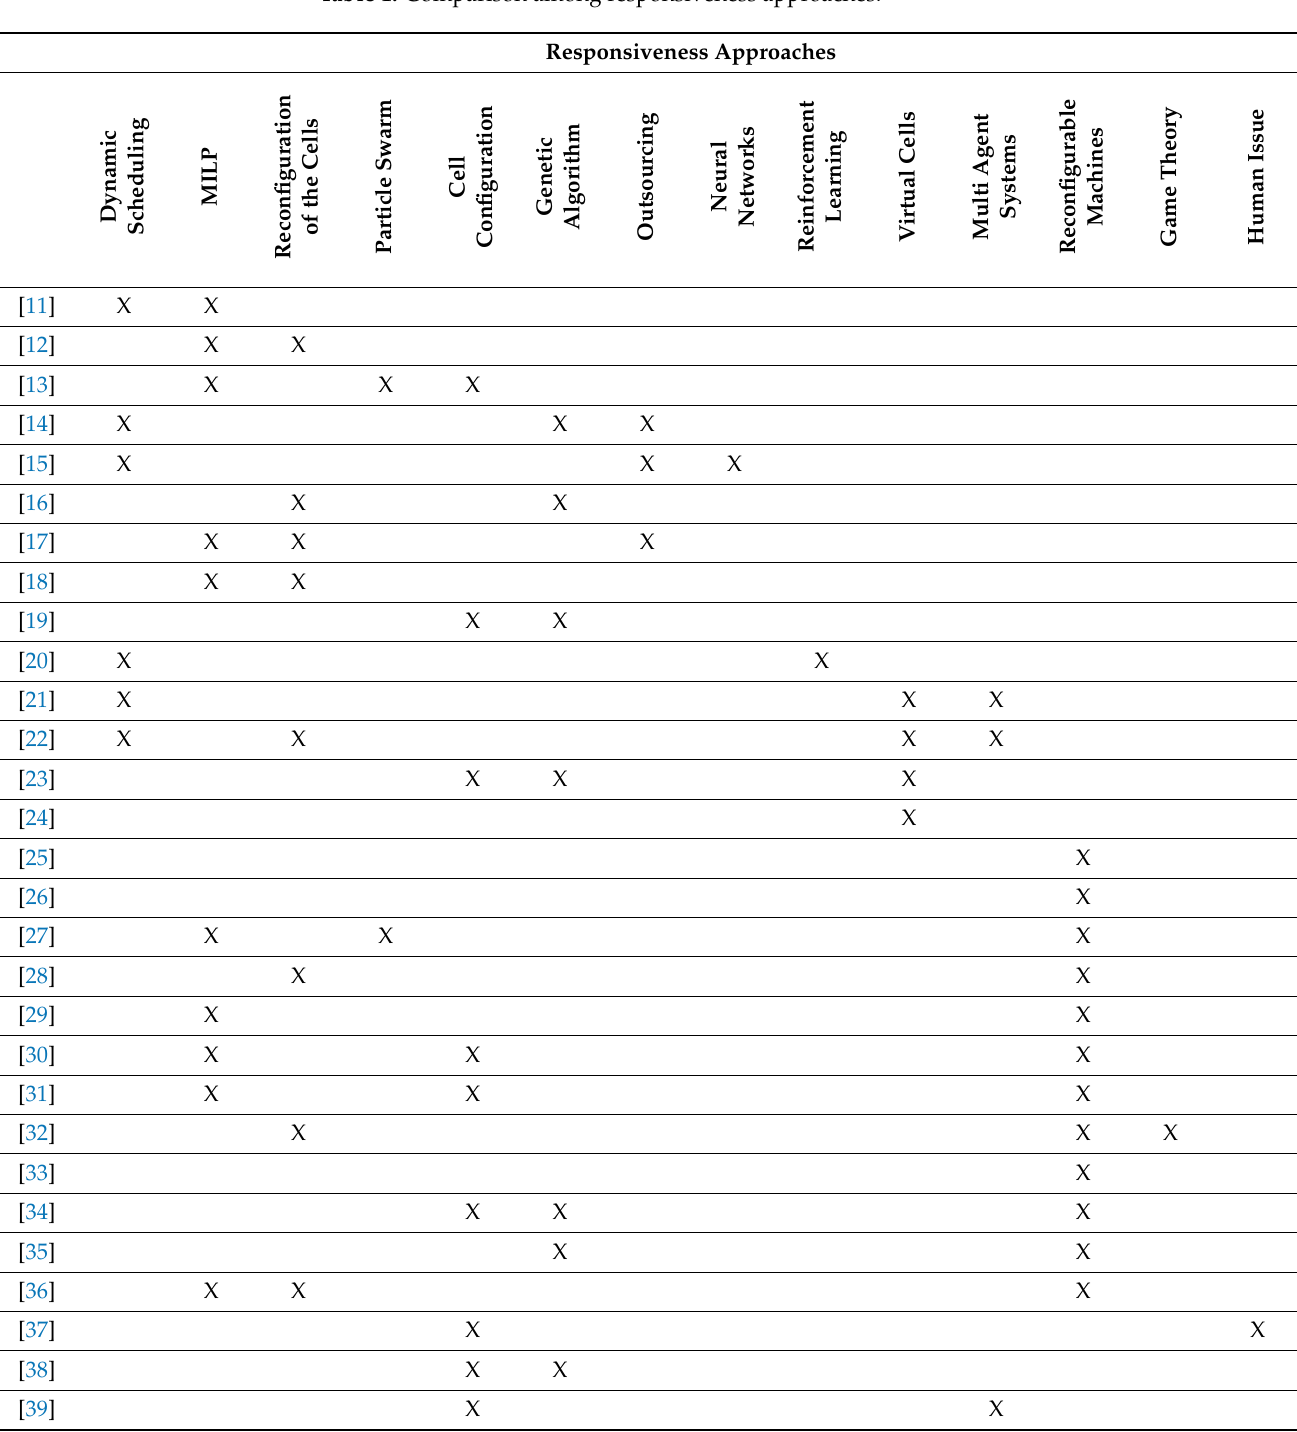
Table 1. Comparison among responsiveness